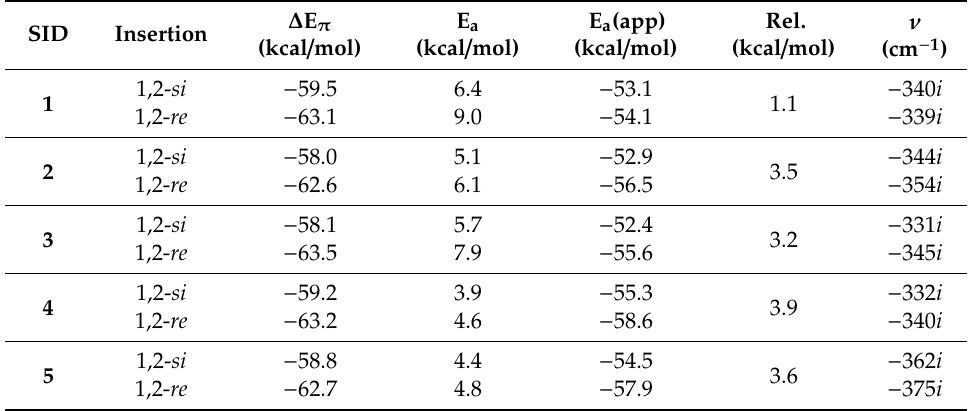
Table 4. The π -complex formation energy ( ∆ E π ), the intrinsic activation energy (E a ), the relative barrier (Rel.), and the apparent activation energy (E a (app)) of the ZN-catalyzed PP polymerization with the five salicylate donors together with values of transition state imaginary frequencies ( ν